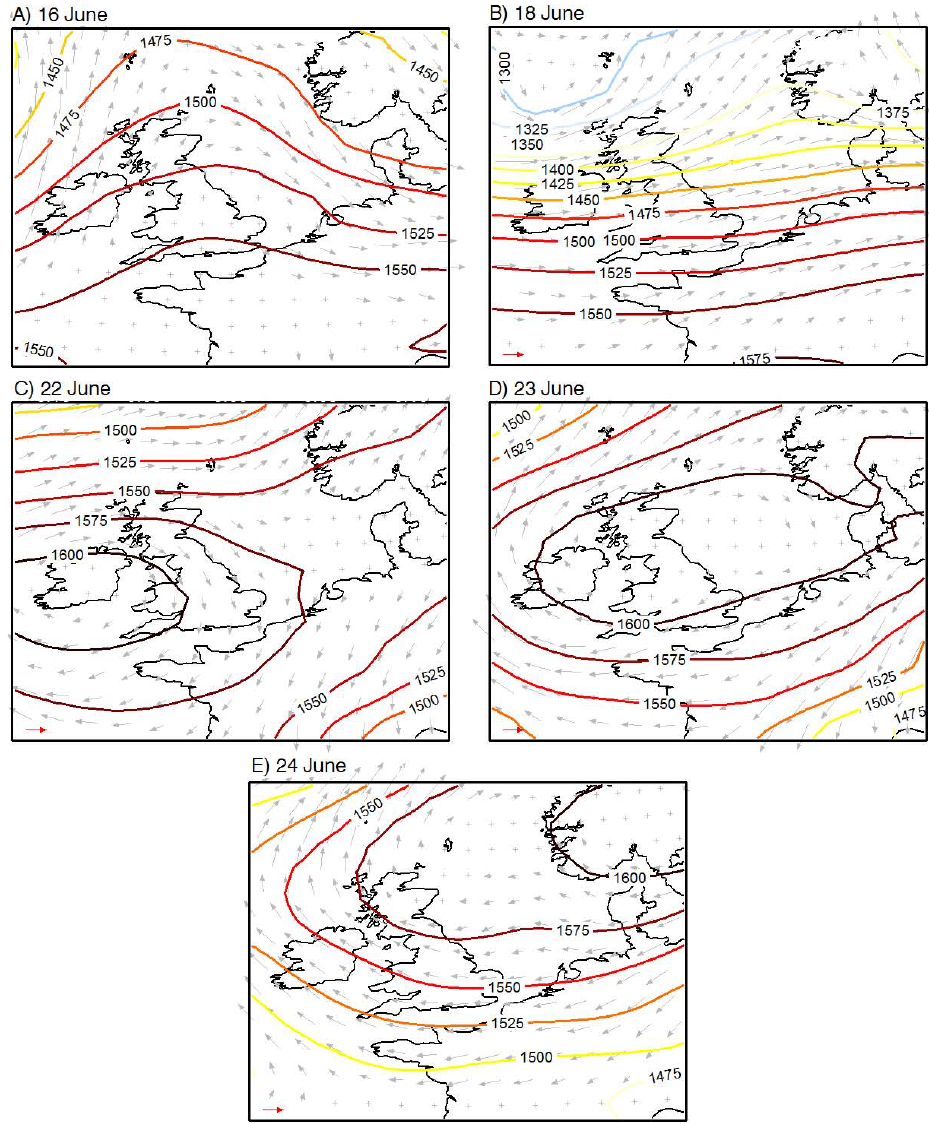
Fig. 2. Maps showing geopotential height and winds from the ERA Interim ECMWF re-analysis at the 850hPa pressure level at 12:00UTC for each flight day. Red arrow in lower left-hand corner indicates 10ms − 1 wind